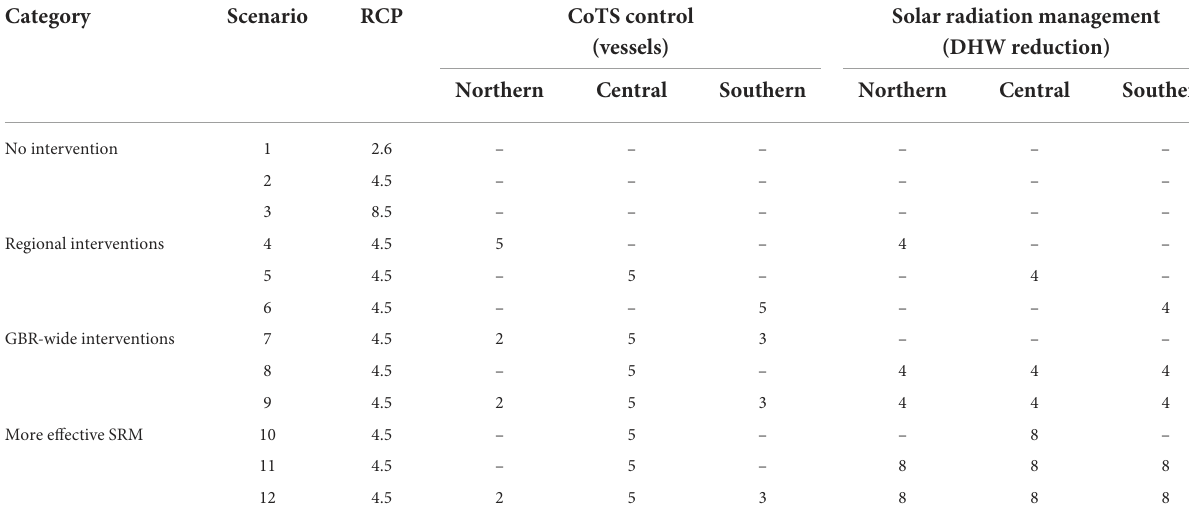
TABLE 1 Definition of model scenarios in terms of climate forcing and the distribution of interventions across the GBR.